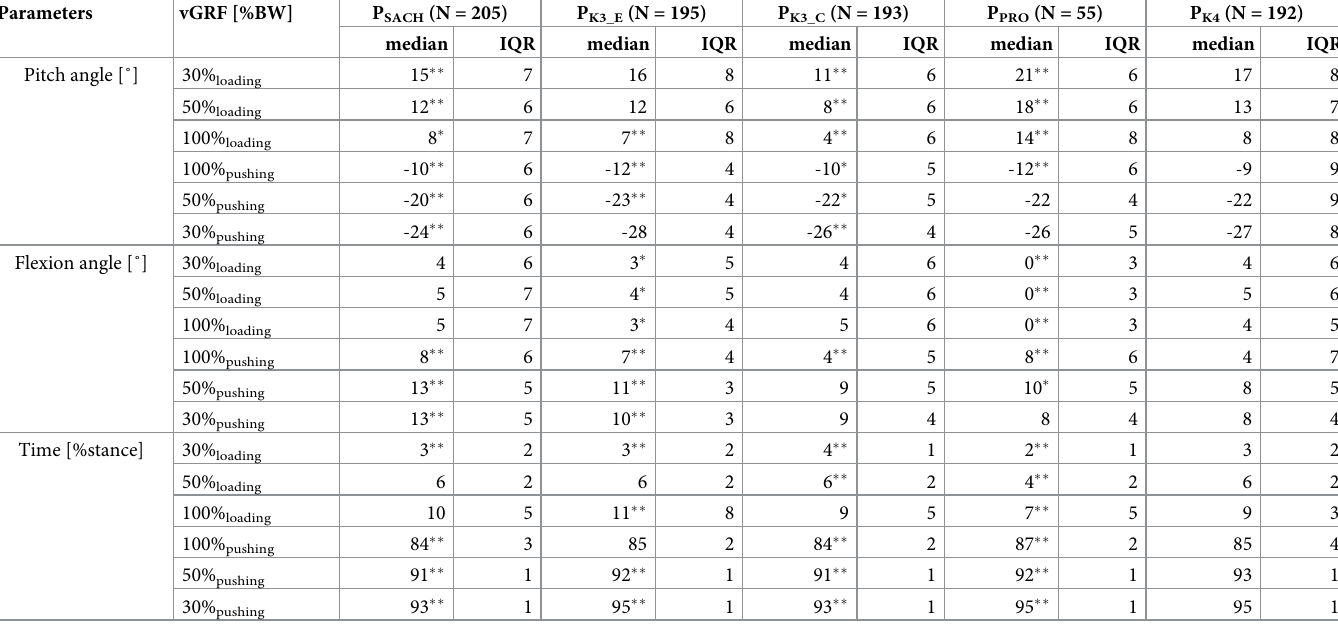
Table 1. Biomechanical specifications of four commercial feet and P PRO& .